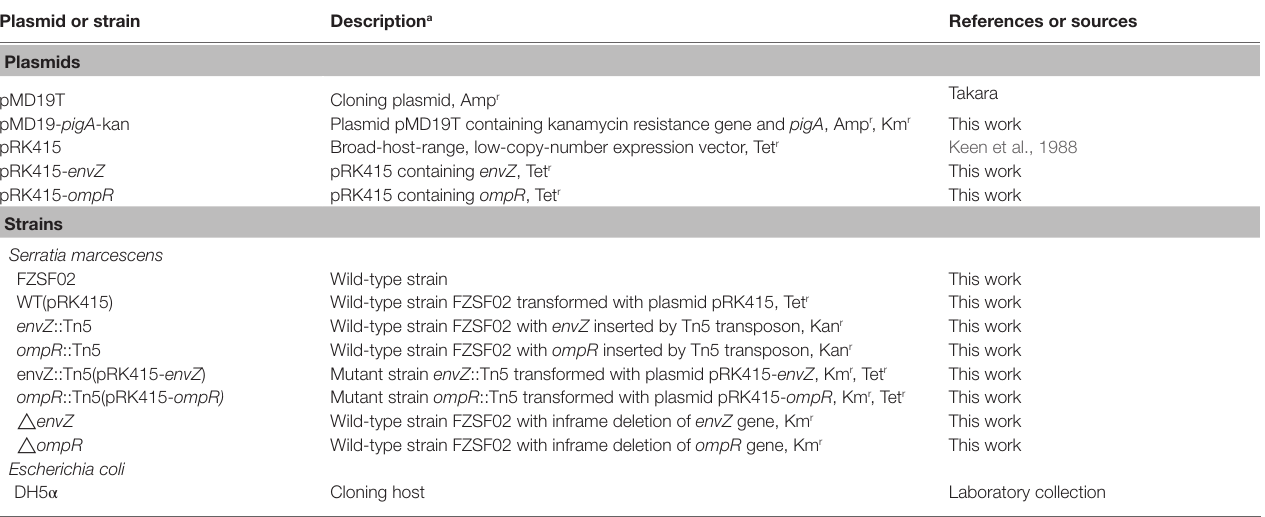
TABLE 1 | Plasmids and strains used in this study. Plasmid or